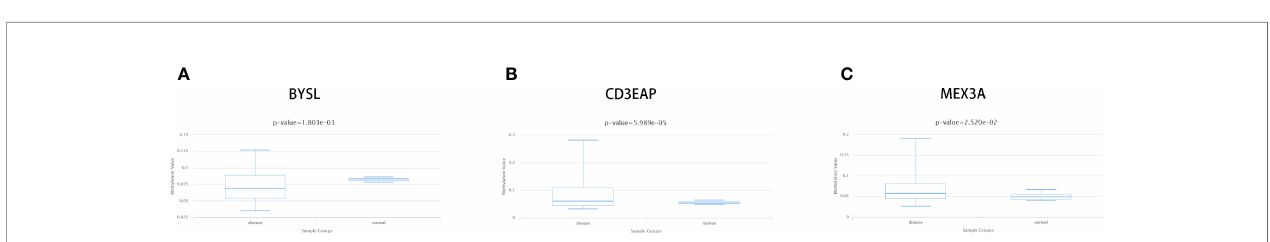
FIGURE 9 | Methylation analyses of STS hub RBPs. The signi fi cant changes of methylation level about (A) BYSL, (B) DD3EAP, and (C) MEX3A between STS and